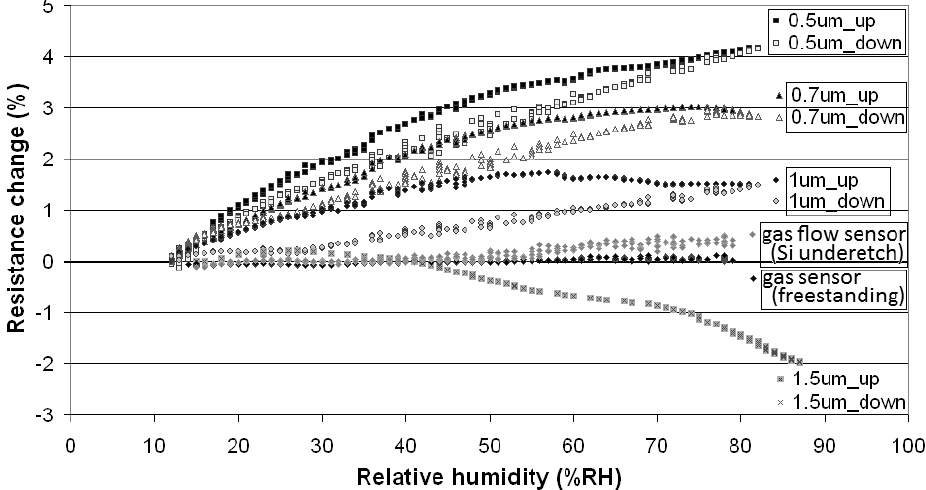
Figure 15. Influence of condensed moisture on the resistance of metal lines for different underlying oxide